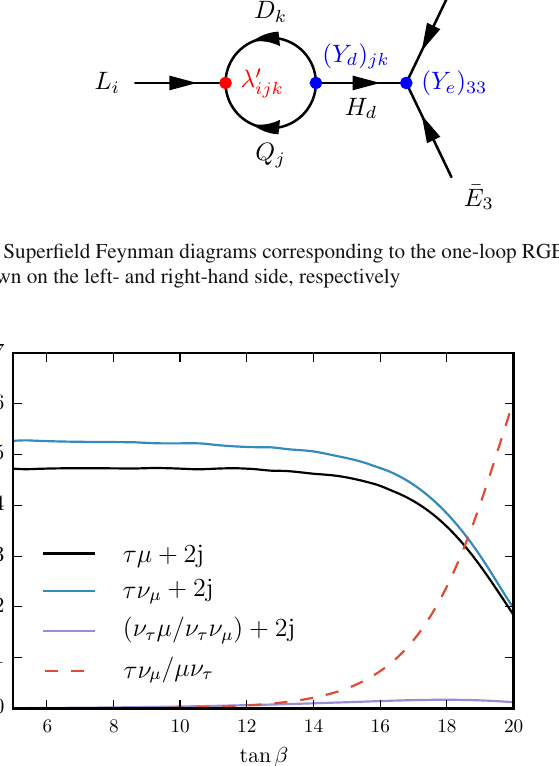
Fig. 7 Branching ratios of the decaying ˜ τ LSP as a function of tan β | = 0 . 07 as well as M = 0 . 2 TeV, M = 1 TeV and using λ (cid:4) GUT 0 1 / 2 211 A 0 = − 1 . 75 TeV. The solid black and blue curves indicate the four- body decay via the neutralino. In solid lavender we show the branching ratio for the four-body decay via the chargino. The dashed red curve denotesthebranchingratioforthetwo-bodydecayviatheRGE-induced coupling λ